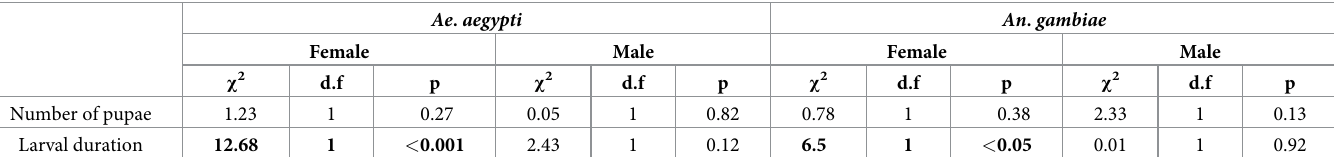
Table 8. Survival and development with significant effects shown in bold